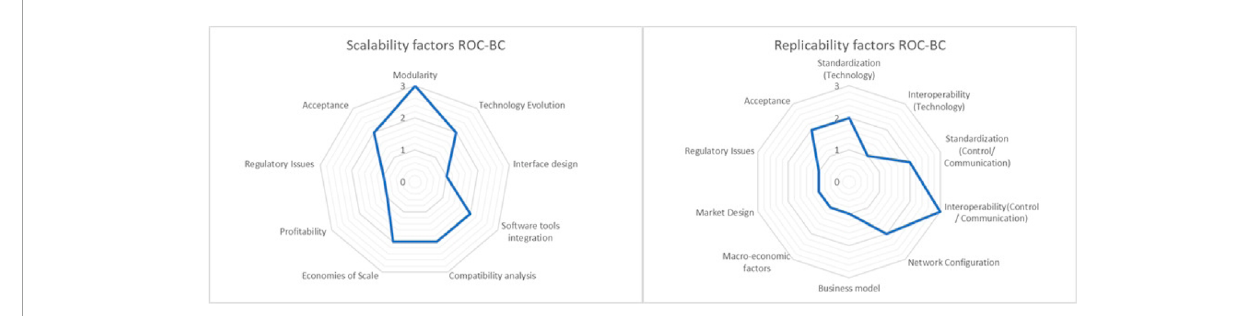
FIGURE 2 Spider graph on ROC-BC scalability and replicability